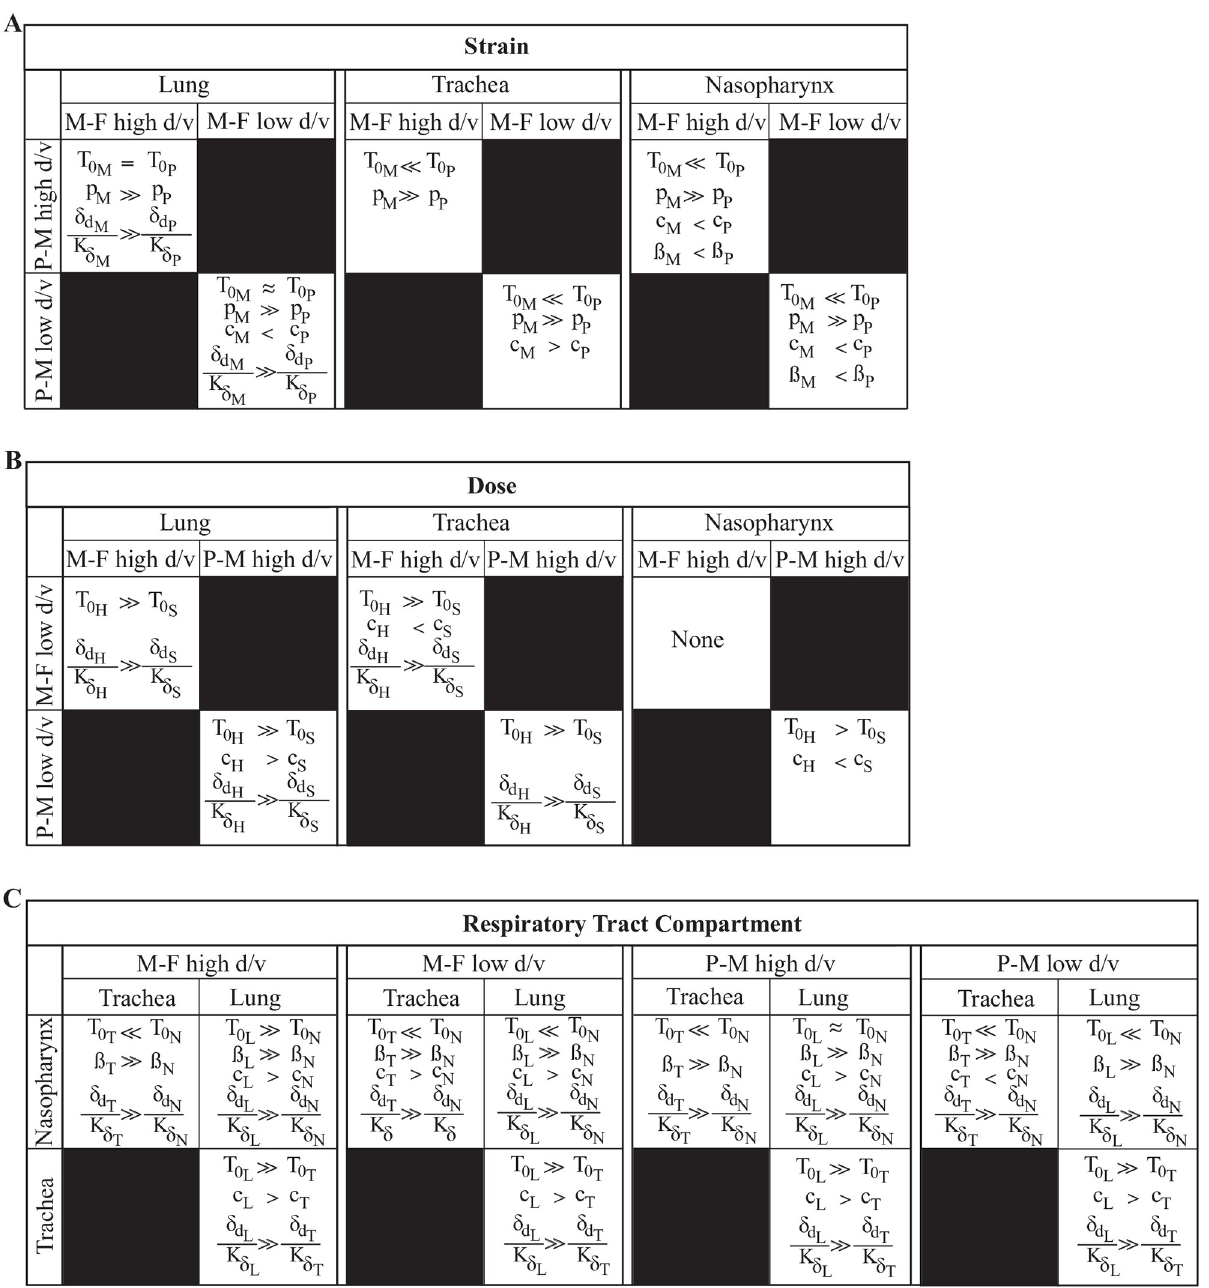
Fig 5. Summary of strain-, dose- and tissue-dependent processes. Summary of parameters that were distinct between different infection scenarios. Parameters consistently different included (A) strain-dependent virus production rates ( p ), (B-C) dose- and tissue-dependent infected cell clearance rates ( δ / K δ ). Other parameters shown include the initial number of target cells ( T 0 ), virus clearance ( c ), and virus infection ( β ). Subscripts “M” and “P” d denote the rSeV-luc(M-F � ) (“M-F”) and rSeV-luc(P-M) (“P-M”) viruses, respectively. Subscripts “L”, “T”, and “N” denote the lung, trachea, and nasopharynx, respectively. Subscripts “H” and “S” denote high d/v and low d/v, respectively.